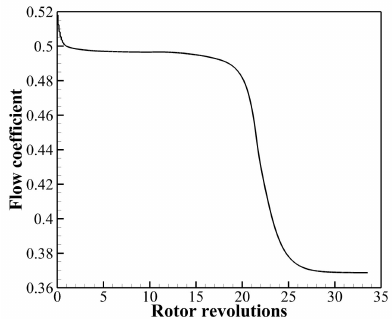
Figure 5. Calculated average flow coefficient versus time.